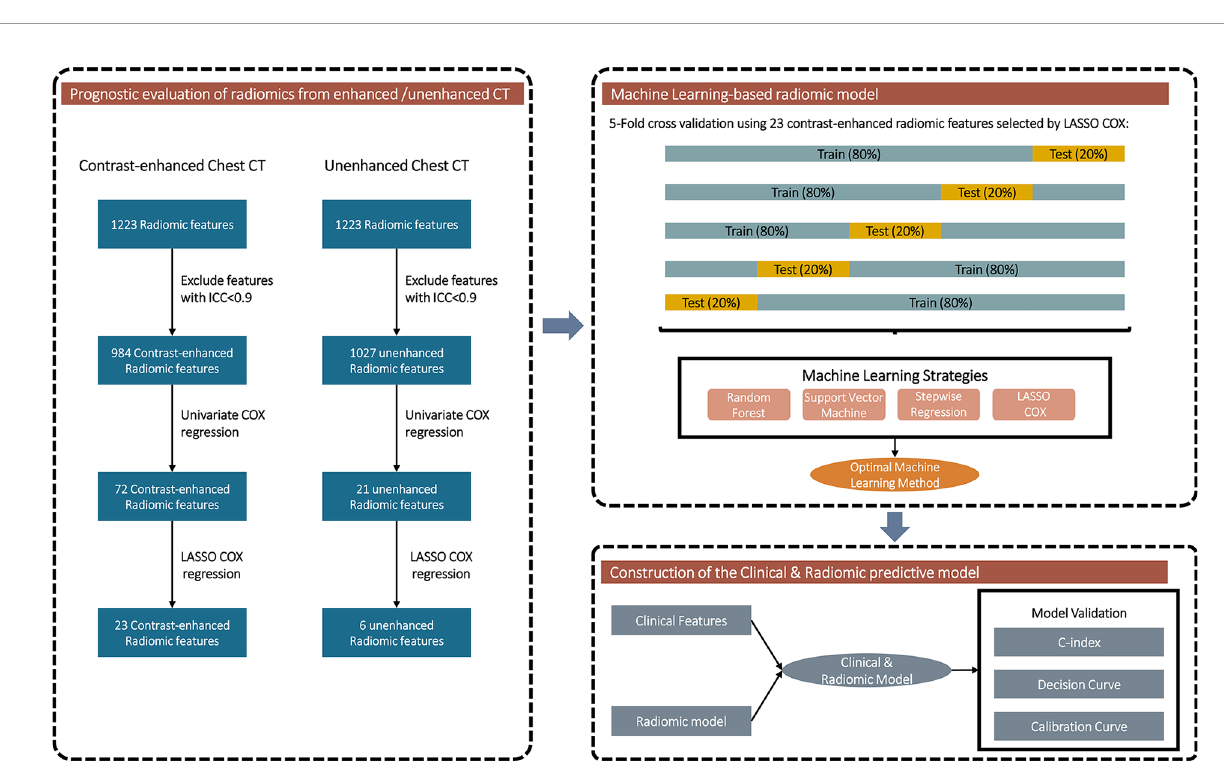
FIGURE 2 | Flowchart exhibiting the general design of the prognostic analyses of the radiomic